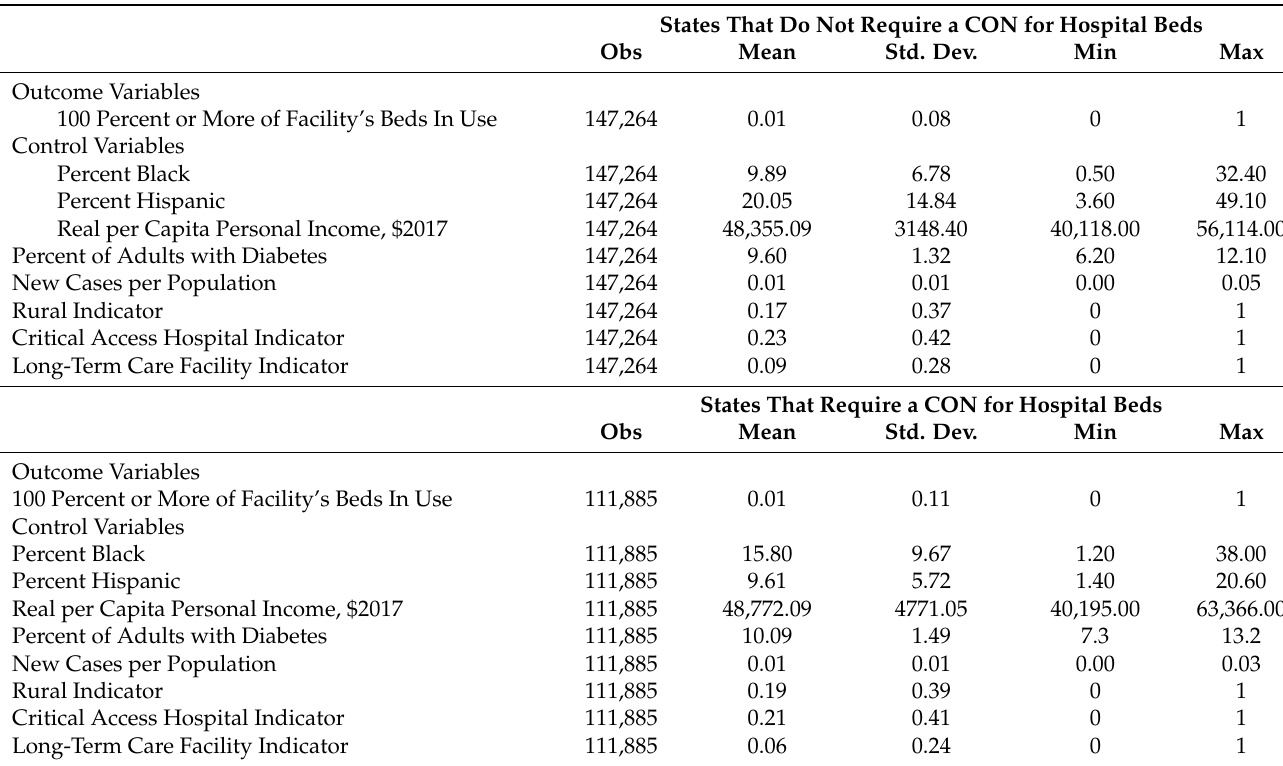
Table 4. Descriptive Statistics, Observations by Hospital and Week, Bed CON and Non-Bed CON